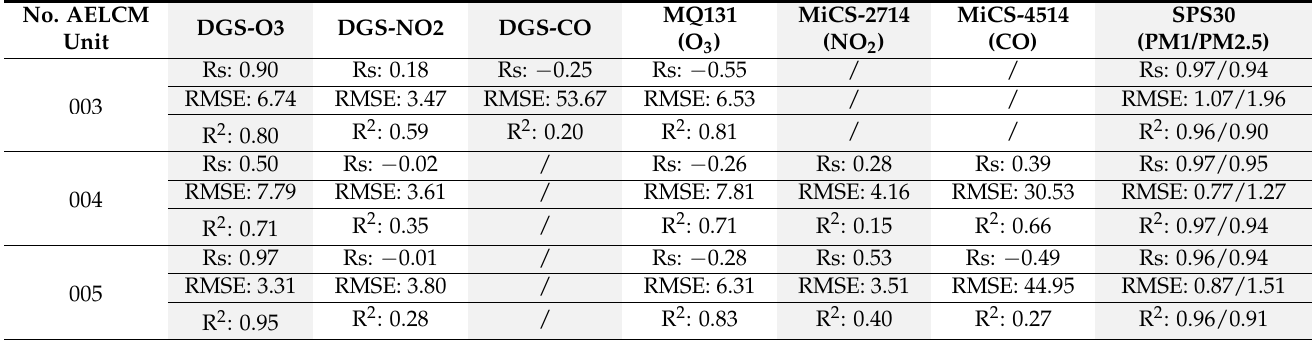
Table 4. Evaluation statistics for every LCS used in the AELCM units: Spearman rank correlation (Rs), root-mean-square error (RMSE) and the coefficient of determination (R 2 ). For the calculation of R 2 and RMSE, all model-adjusted LCS data (hourly gas [ppb] and 15 min PM concentration means [ µ g/m 3 ]), while for Rs all raw LCS data for every individual sensor are used (excluding the data taken during the warm-up duration). The AEMS data are used as reference. For all LCS data, besides the SPS30, the RMSE is in ppb. For SPS30 data, the RMSE is in µ g/m 3